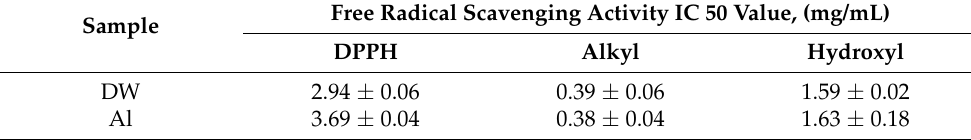
Table 2. Free radical scavenging activities of